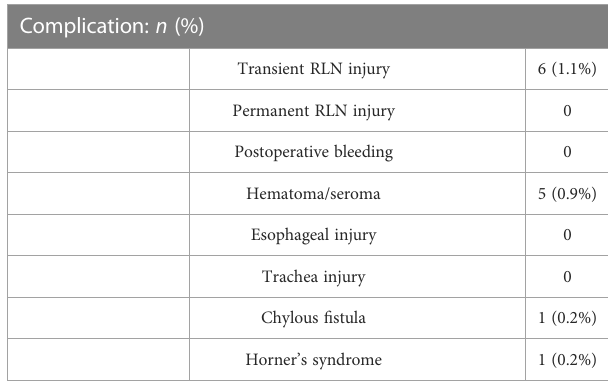
TABLE 2 The complication rates of PTC patients underwent ET via GUA approach with fi ve-settlement